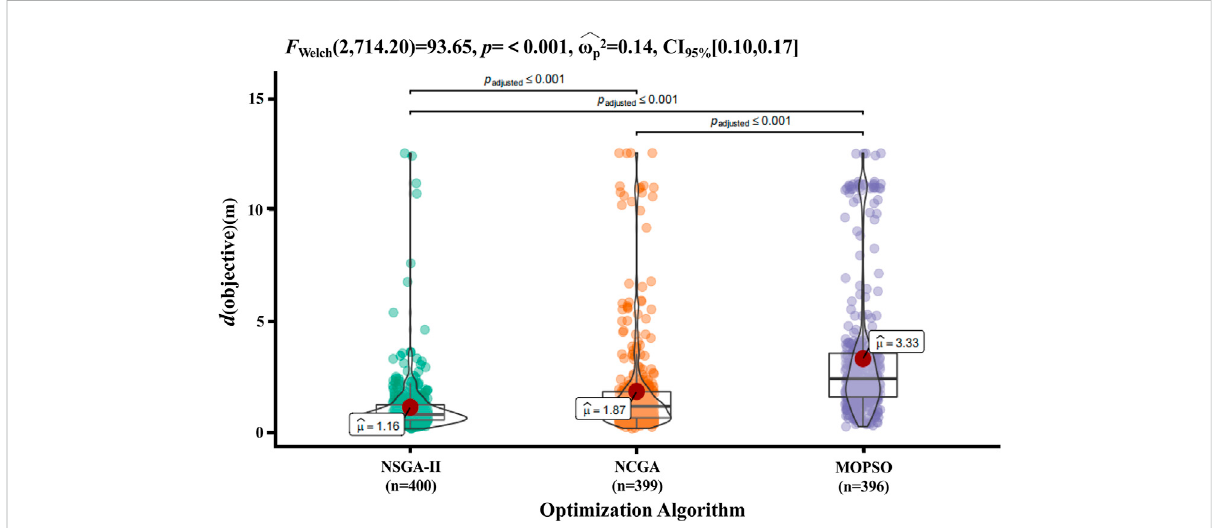
FIGURE 8 Objective function distribution of different multiobjective optimization algorithms. Data were analysed by one-way ANOVA, and the results were considered statistically signi fi cant when p < 0.05. The red dots indicate the average value of the objective function for each algorithm after removing the outliers.